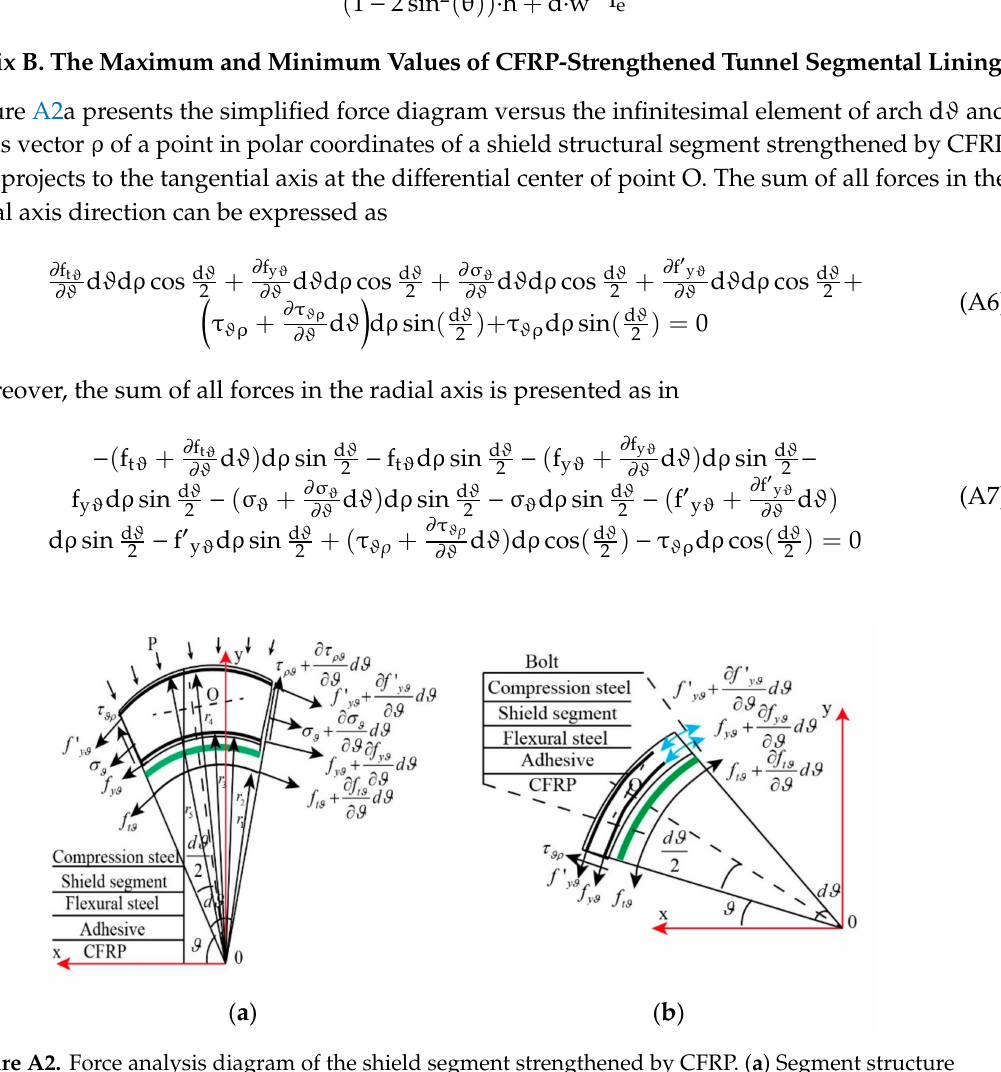
Figure A2. Force analysis diagram of the shield segment strengthened by CFRP. ( a ) Segment structure strengthened by CFRP, ( b ) segment joint strengthened by